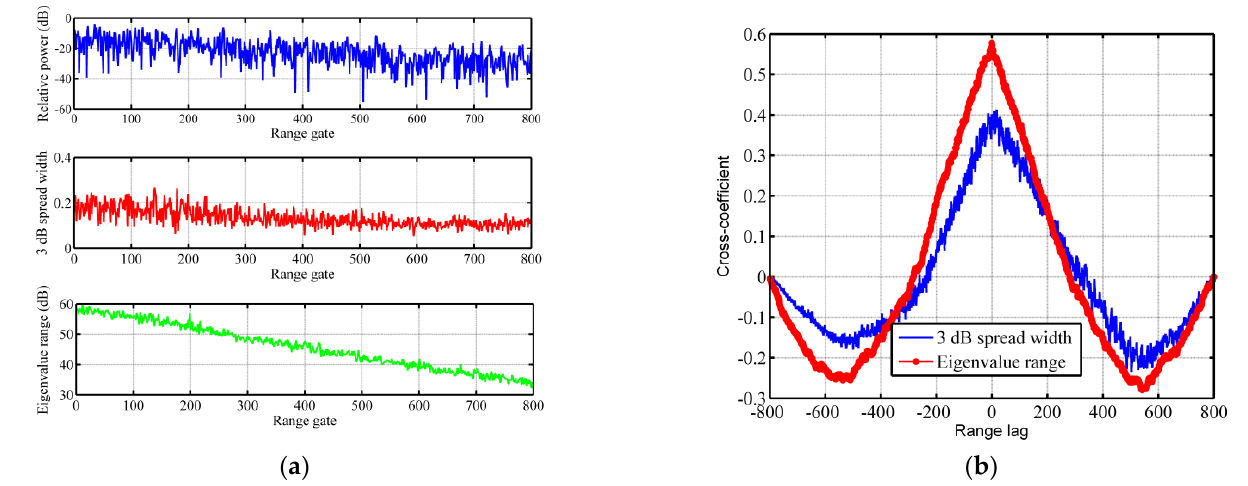
Figure 12. Cross-correlation analysis: ( a ) equivalent backscattering coefficient of sea clutter, 3 dB spread width and the range of the eigenvalue; ( b ) cross-covariance between equivalent backscattering coefficient of sea clutter and 3 dB spread width and between equivalent backscattering coefficient of sea clutter and the range of eigenvalue.